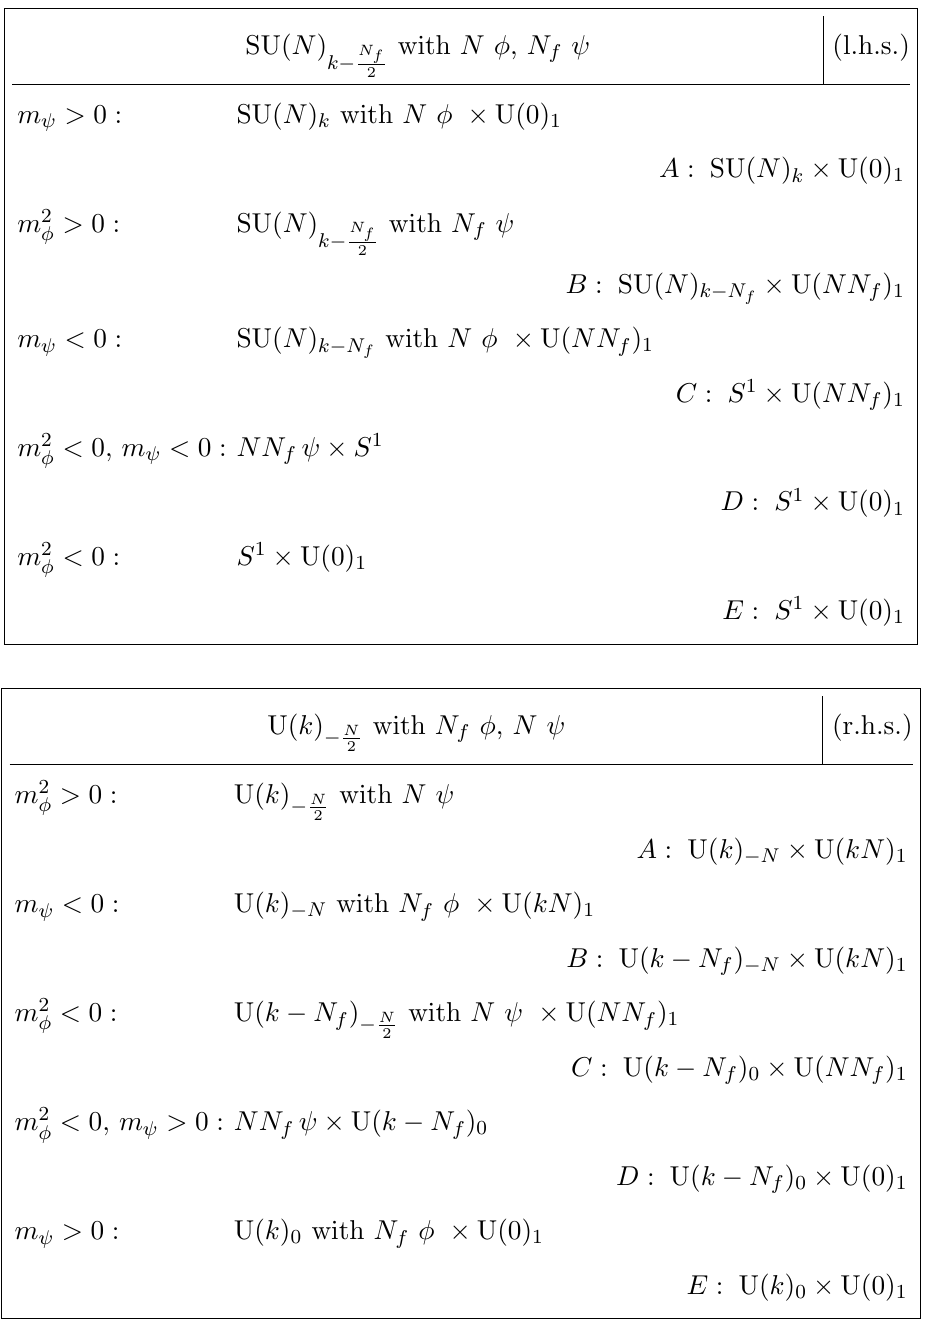
Table 2 . Phase diagram of the SU / U dualities, for N = N s and k